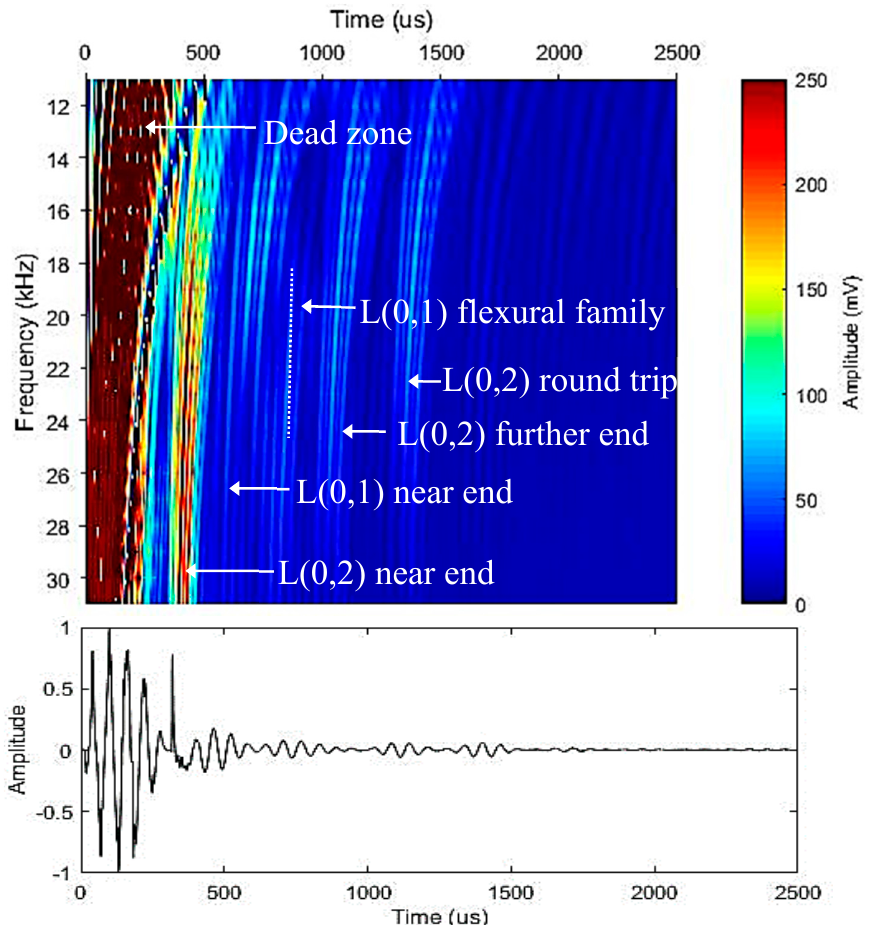
Figure 6. Experimental results over a range of frequency for excitation using 14 transducers and its corresponding time-domain results at 16 kHz.